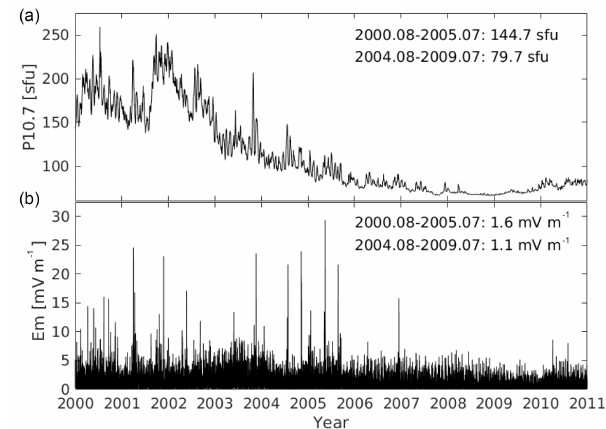
Figure 2. The variations of solar flux index (P10.7, a ) and solar wind merging electric field ( E m , b ) from 2000 to 2010. The mean values of two parameters, P10.7 ref and E m , during two 5-year ref periods (from August 2000 to July 2005 and from August 2004 to July 2009, respectively) are given in the upper part of each